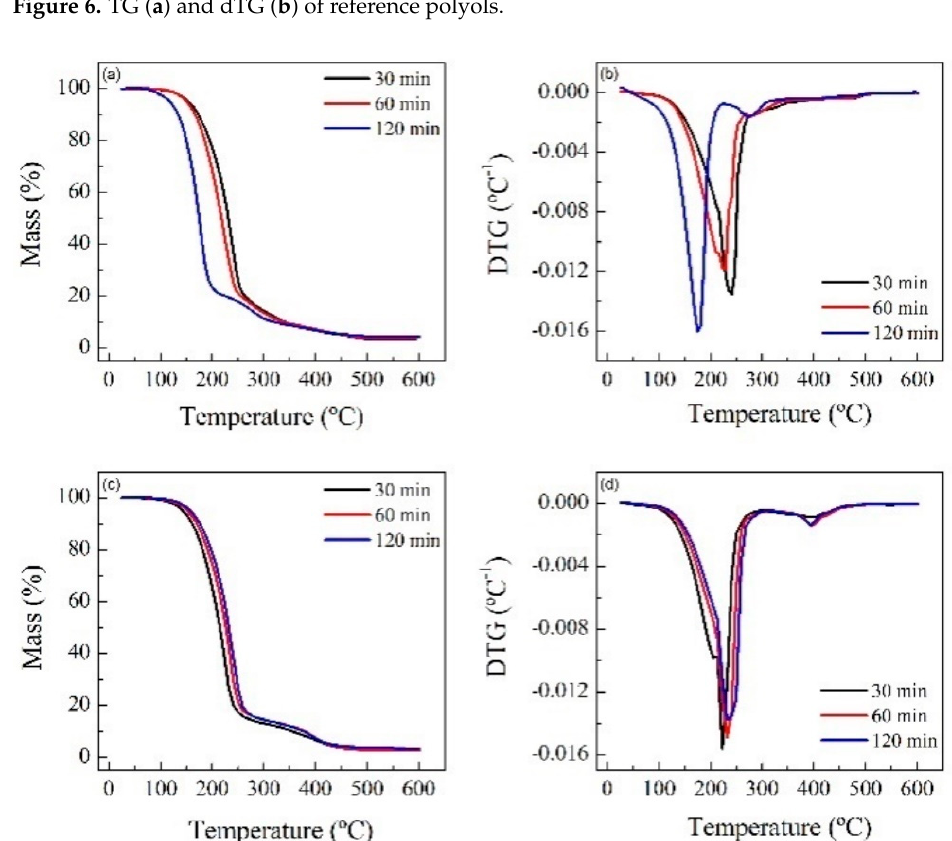
Figure 7. TG and dTG analysis of the products obtained in the reactions at 200 ° C, 2 h, PUR/solvent ratio = ¼, and NaOH catalyst (0.002 mol/g) of the residues: RPUF ‐ B ( a , b ) and RPUF ‐ C ( c , d ).